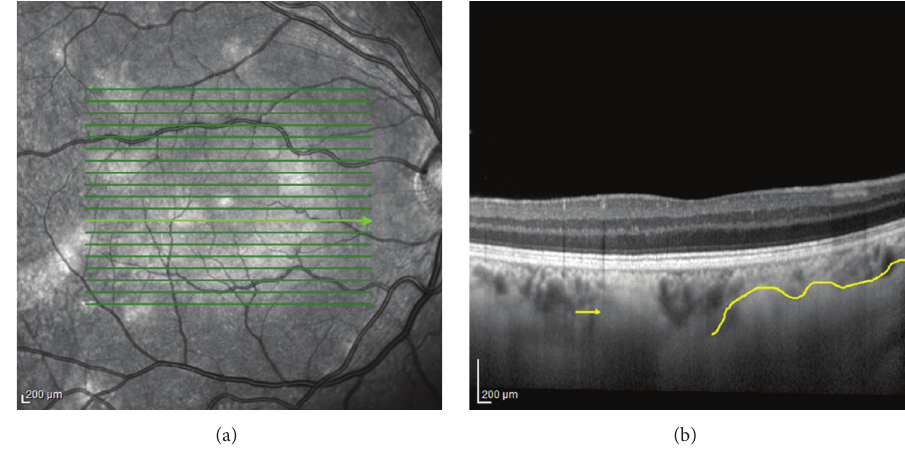
Figure 5: Raster (a) and corresponding cross-sectional (b) enhanced depth spectral domain optical coherence image of choroidal nodules in neurofibromatosis type 1. The delineated area shows a laterally extending placoid type choroidal nodule whereas the arrow indicates a dome-shaped